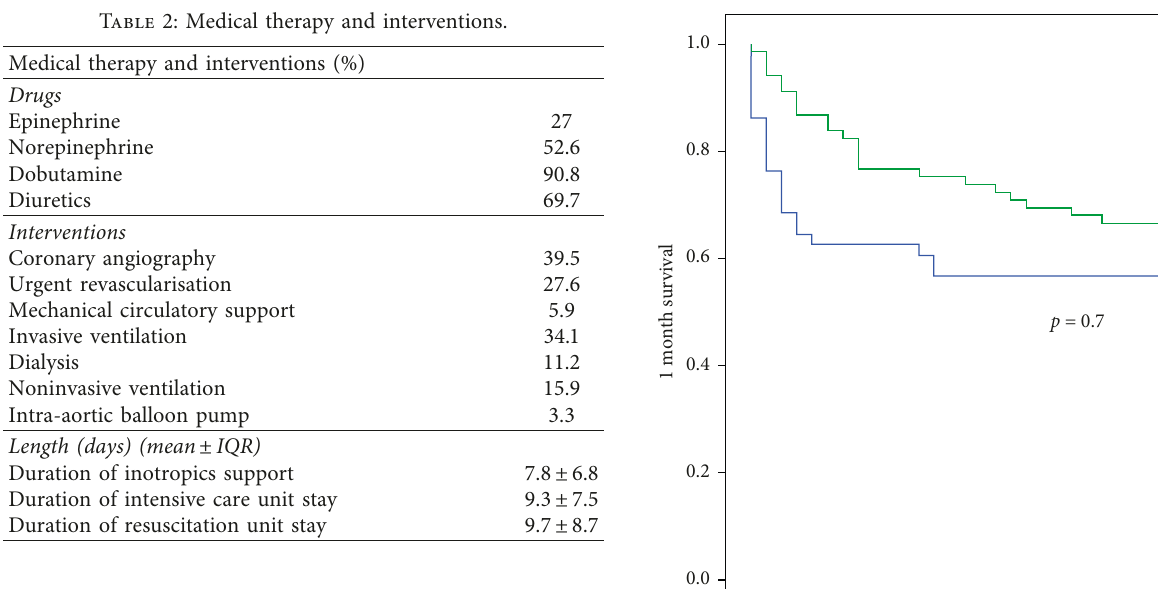
Table 3: In-hospital complications.